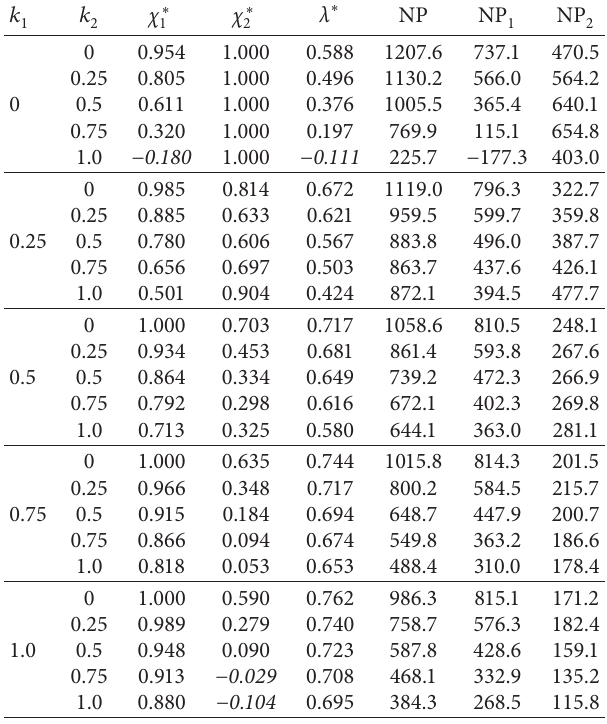
and the fairness concern behavior of both 2